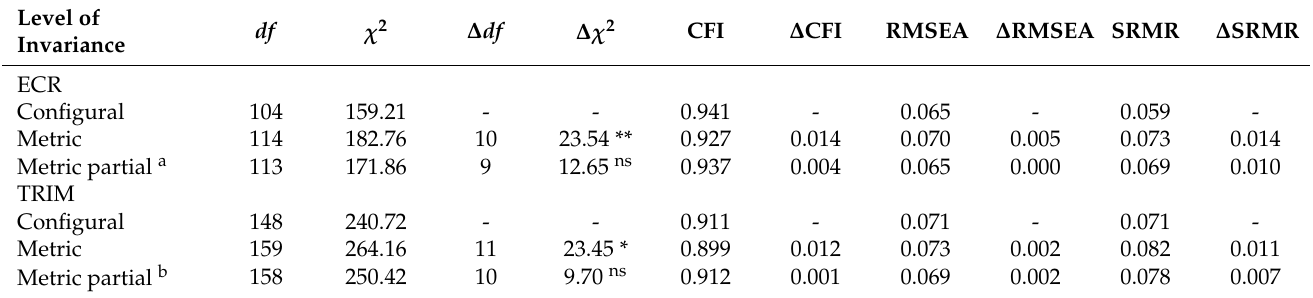
Table 3. Measurement invariance testing of ECR and TRIM.